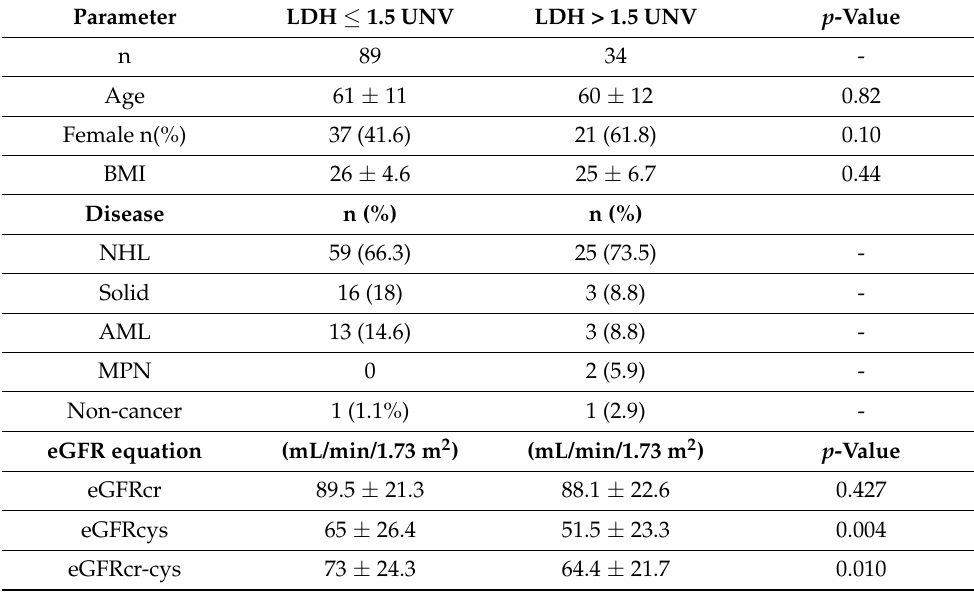
Table 2. Subgroup analysis between LDH ≤ 1.5 UNV and LDH > 1.5